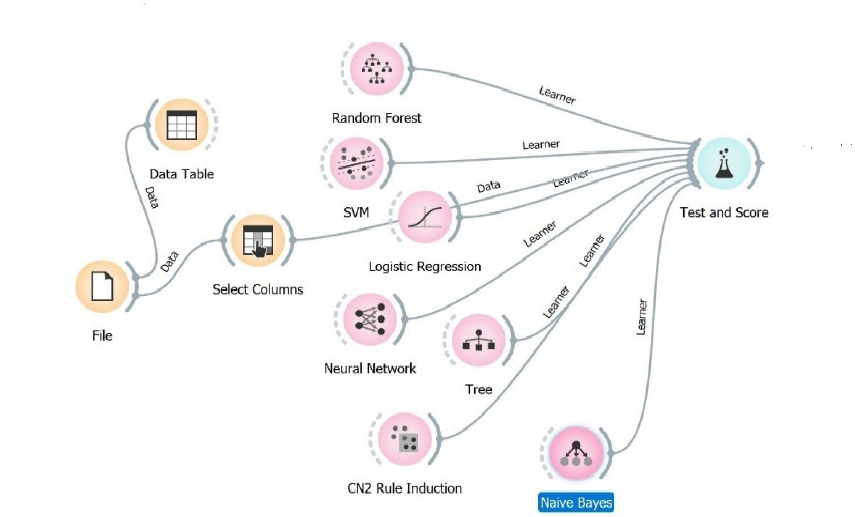
Fig. 23 . The workflow diagram for the